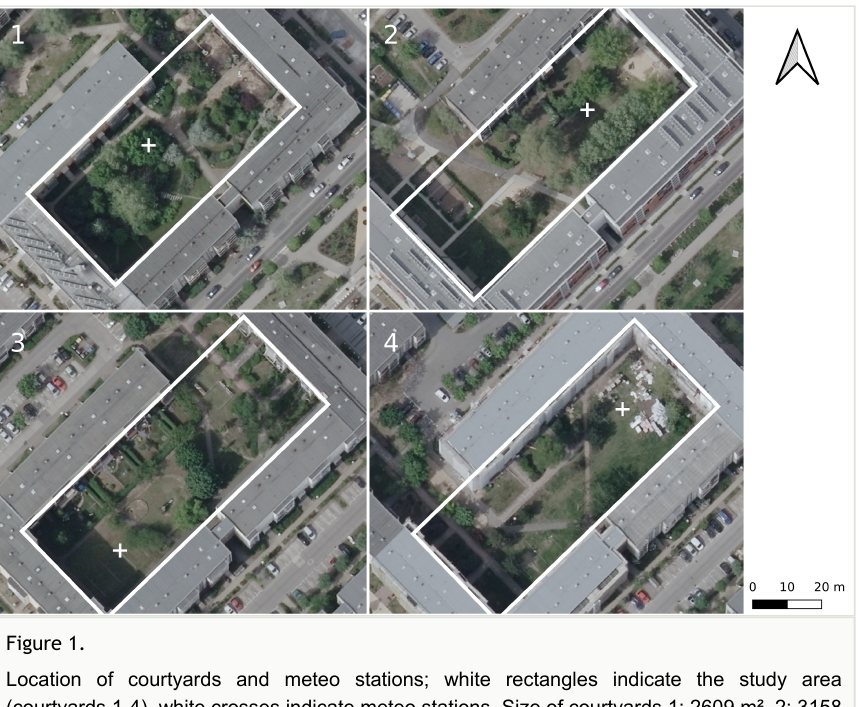
Figure 1. Location of courtyards and meteo stations; white rectangles indicate the study area (courtyards 1-4), white crosses indicate meteo stations. Size of courtyards 1: 2609 m², 2: 3158 m², 3: 3114 m², 4: 3141 m²; data: